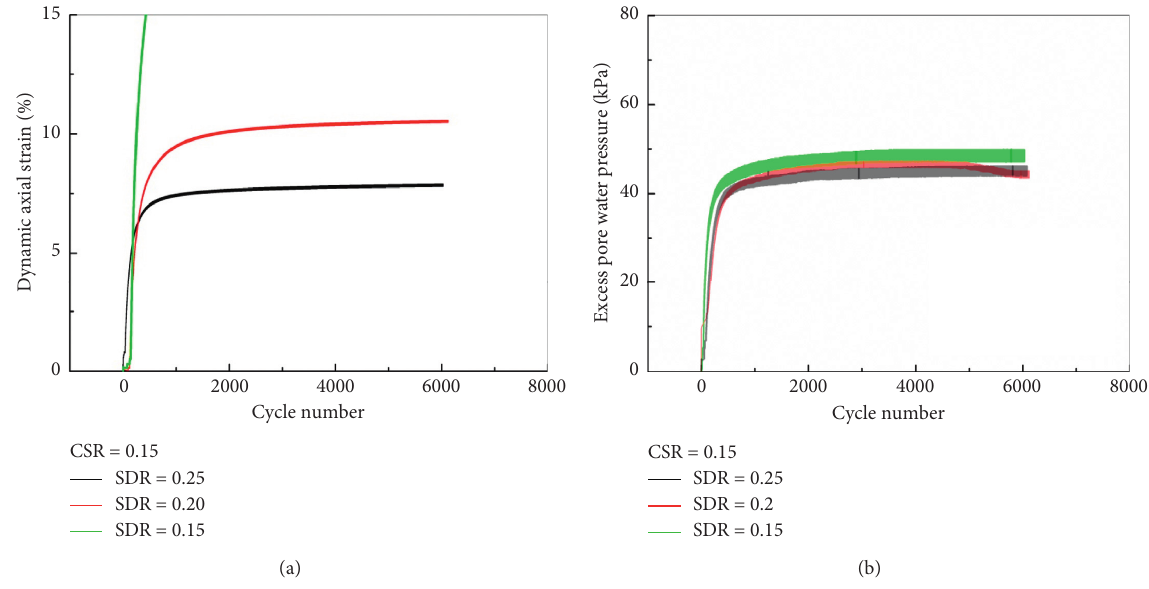
Figure 5: Dynamic response of soil specimen at different SDR: (a) dynamic axial strain; (b) excess pore water